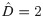
Macaque visual system positioning.The left panel shows the node positions determined by the physical distances between the ROI. The connectivity in the left panel consists of the observed and present connections in the data. The right panel shows the posterior expectations of node distances as determined by the latent space model, with optimal dimensionality D^=2. Note positions are approximated using multidimensional scaling, based on the distances on the cortex and the posterior expectation of distances in the latent space.